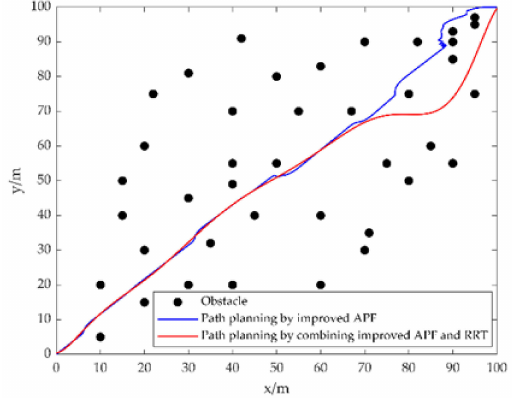
Figure 7. The path planned by the two methods.